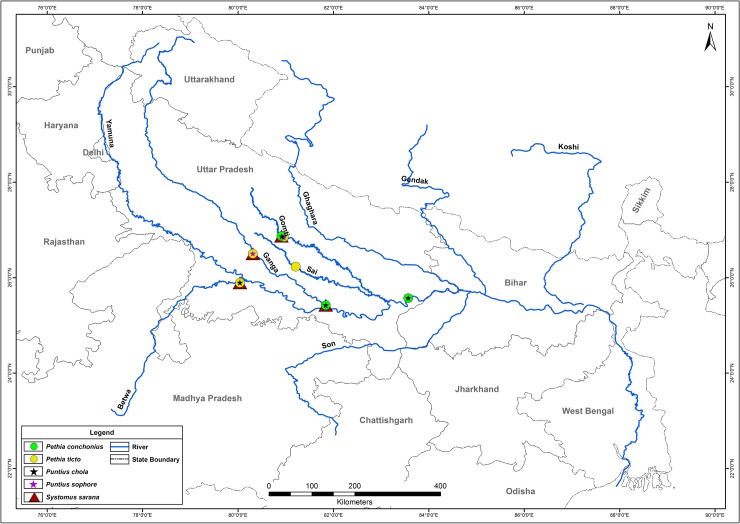
Map showing different sampling sites of selected species.